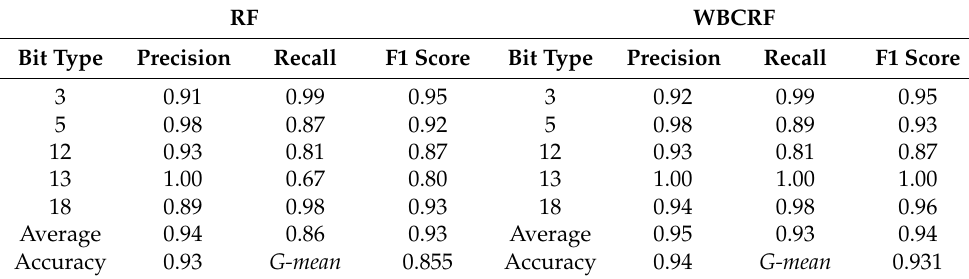
Table 13. The selection of 8.5” bits through RF and WBCRF models.